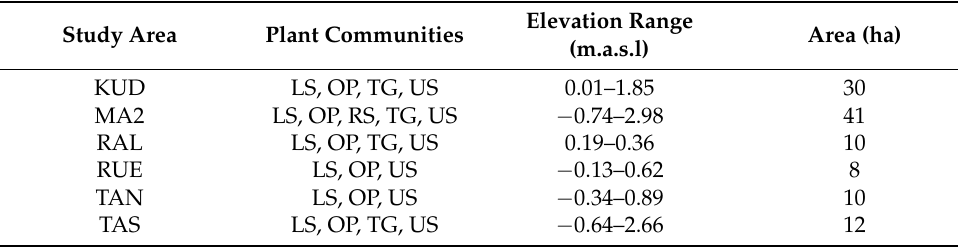
Table 1. Plant communities sampled in each study area, elevation range and area. LS: Lower Shore; OP: Open Pioneer; RS: Reed Swamp; TG: Tall Grassland; US: Upper Shore.